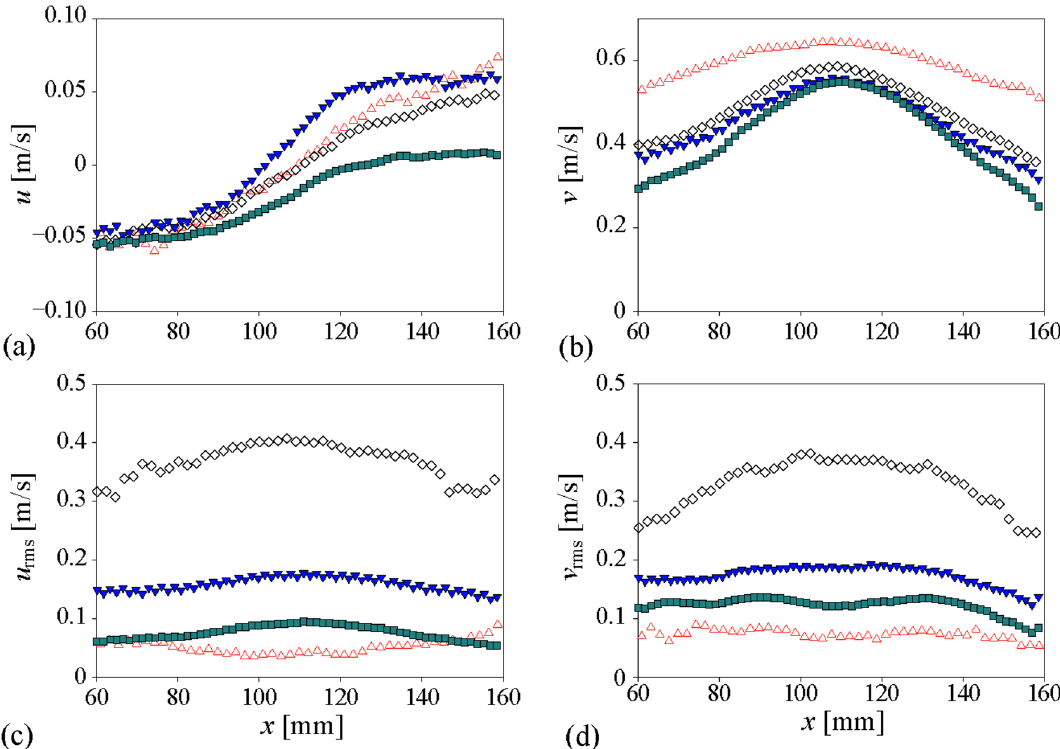
Figure 10. Bubble velocity profiles in the dense bubble plume: ( a ) time-averaged horizontal velocity; ( b ) time-averaged vertical velocity; ( c ) horizontal r.m.s. velocity fluctuation; ( d ) vertical r.m.s. velocity fluctuation. Open triangle, Lukas-Kanade; open diamond, Farnebäck; filled square, pre-trained CNN-based model; inverted filled triangle, fine-tuned CNN-based model. All velocities were averaged along the vertical ( y ) direction in the measurement